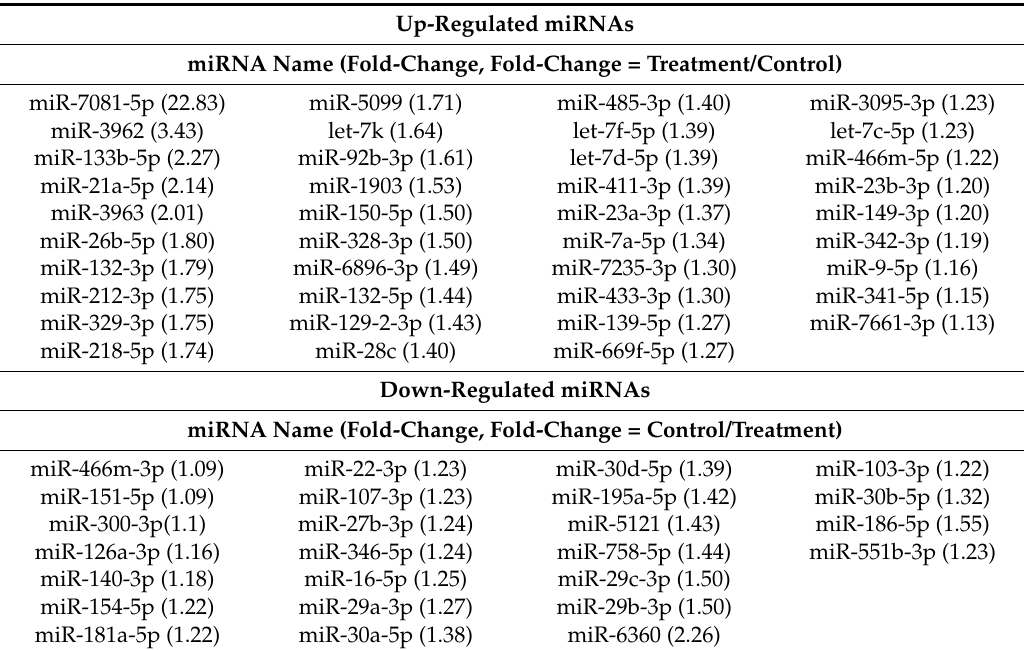
Table 1. Up-regulated and down-regulated hippocampal miRNAs upon fluoxetine treatment. Up-Regulated miRNAs miRNA Name (Fold-Change, Fold-Change =